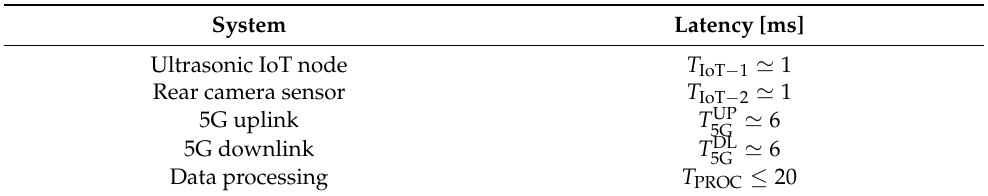
Table 3. Average values (based on experimental data) of the latencies involved in the proposed 5G/XR/IoT